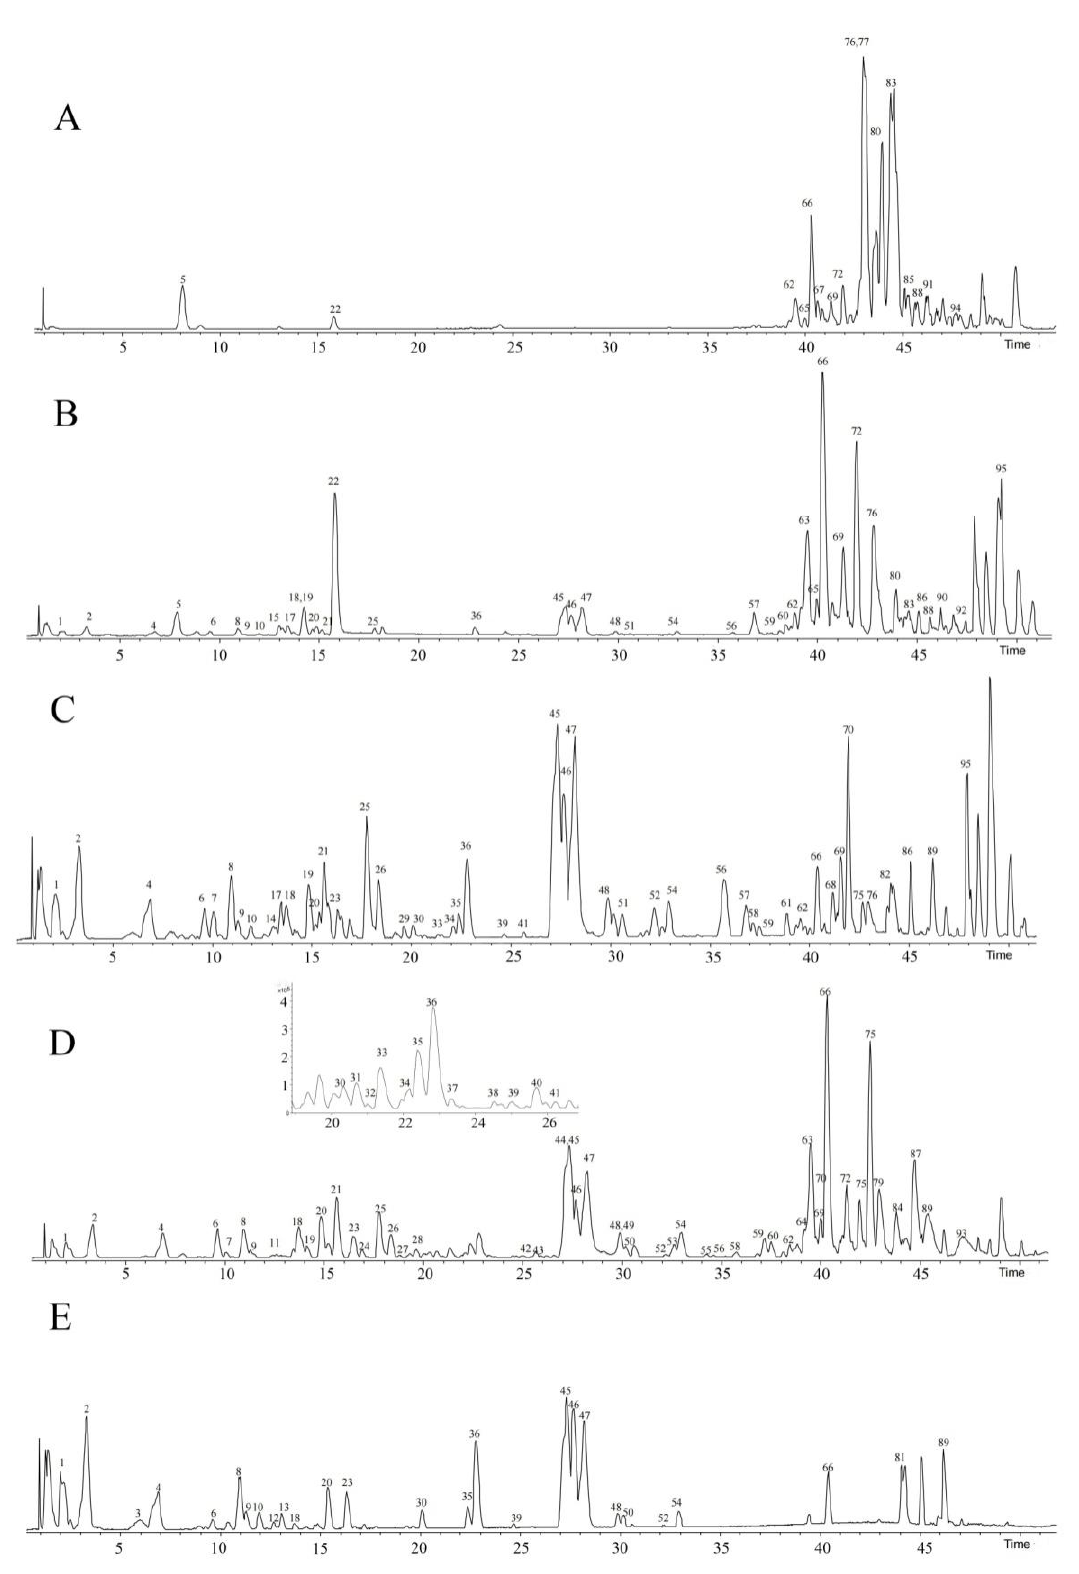
Figure 1. Base peak chromatogram (BPC) of different fractions from the Paris polyphylla var. chinensis leaves (PPL) in positive ion mode. ( A ). Petroleum ether fraction; ( B ). chloroform fraction; ( C ). ethyl acetate fraction; ( D ). n-butanol fraction; ( E ). water fraction.